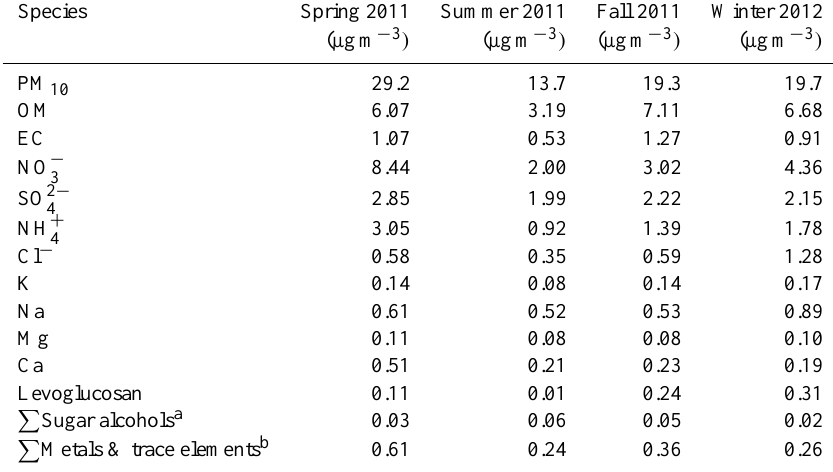
Table 1. Average measured concentrations of PM 10 and its major components in spring, summer, fall and winter 2011–2012.